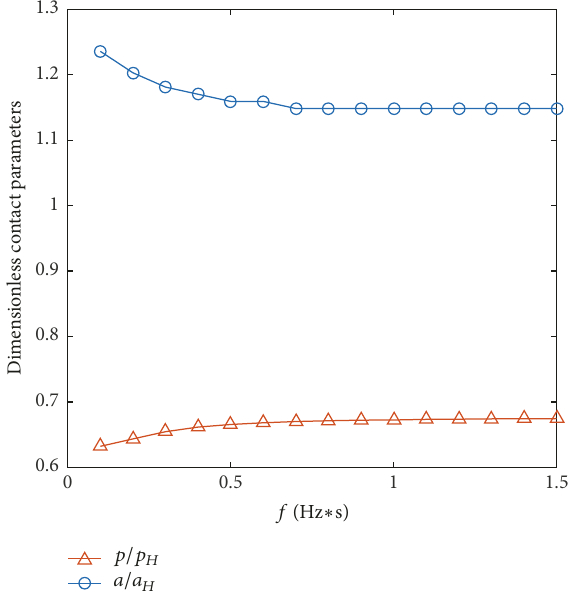
Figure 10: Amplitude of peak contact pressure and contact radius versus excitation frequency.